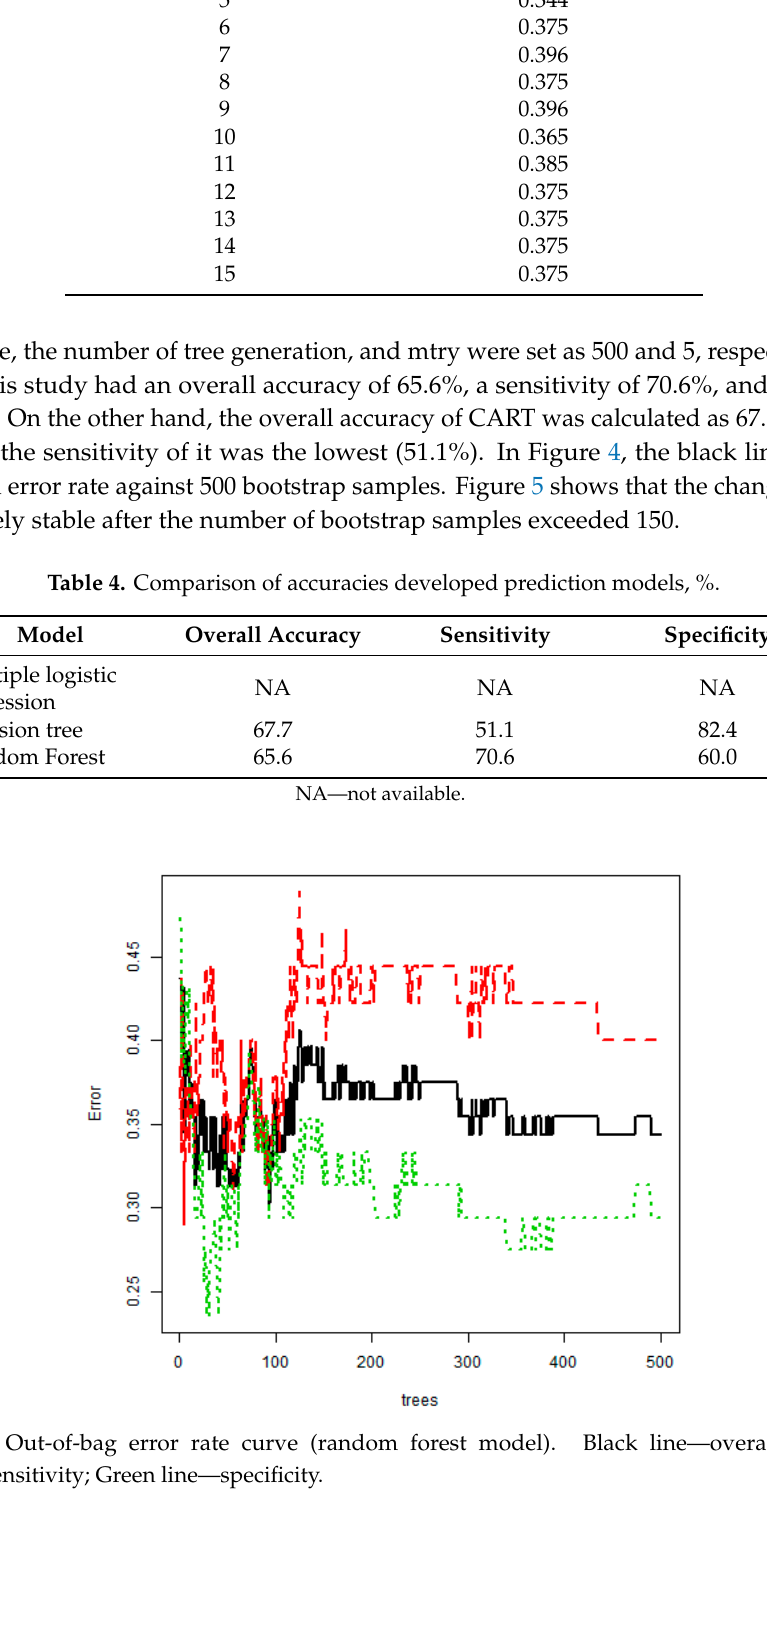
Table 3. Error of out-of-bag.